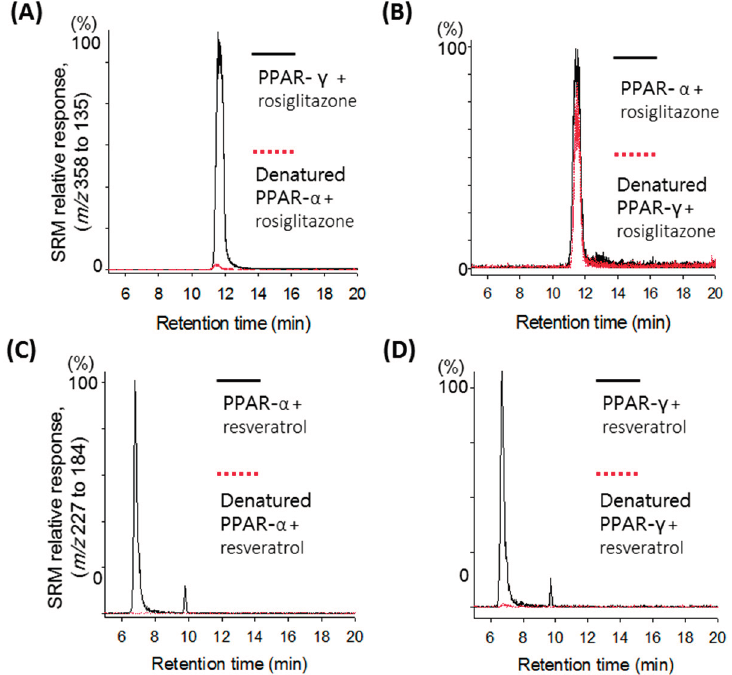
Figure 1. Ultrafiltration LC-MS screening of rosiglitazone and resveratrol for binding to PPAR γ and PPAR α . Denatured receptor was used as a control for nonspecific binding (dotted line). Enhancement of the rosiglitazone peak compared with the control